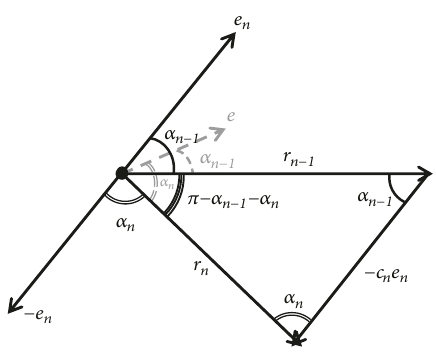
Figure 1: An illustration for certain steps of the proof of Theorem 3. All vectors except 𝑒 lie in the vertical plane; 𝑒 (as well as 𝑟 𝑛−1 ) lies in the horizontal plane; 𝑒 represents any vector from the set {𝑒 ,𝑒 , −𝑒 ,−𝑒 , .. . , −𝑒 } . The spherical law of cosines is applied −1 0 1 2 𝑛−1 to angles formed by the vectors 𝑟 𝑛−1 , 𝑟 𝑛 , 𝑒 . The law of sines is applied to the triangle formed by vectors 𝑟 𝑛−1 , 𝑟 𝑛 , −𝑐 𝑛 𝑒 𝑛